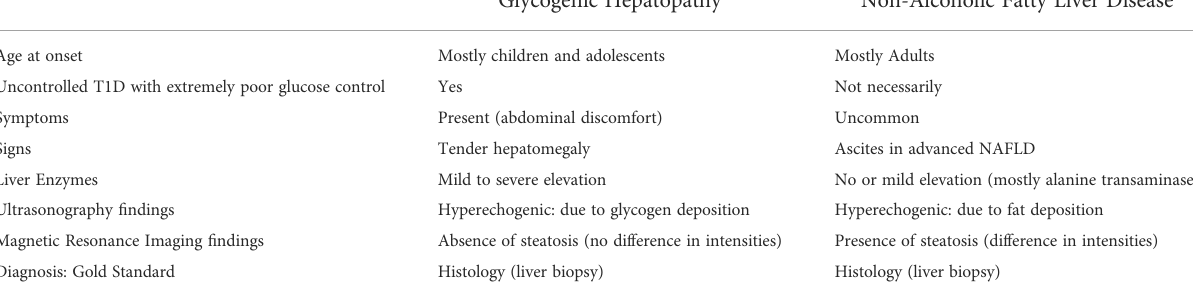
TABLE 2 Comparison between Glycogenic Hepatopathy and Non-Alcoholic Fatty Liver Disease (NAFLD). Glycogenic